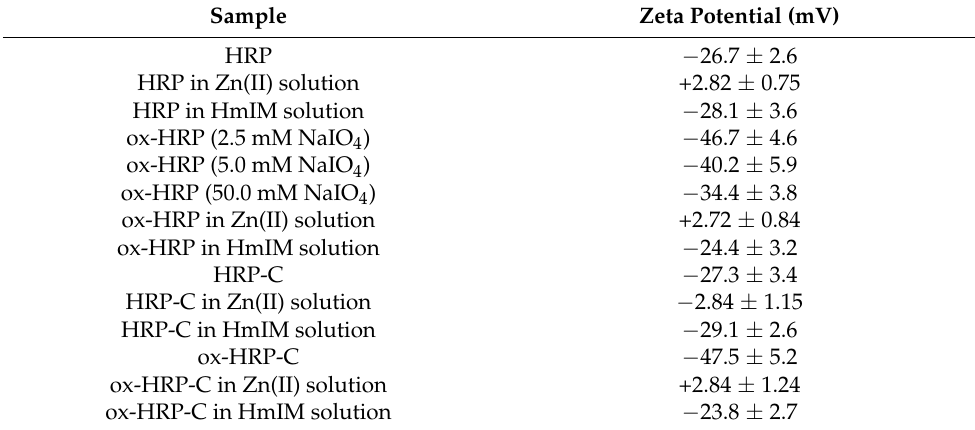
Table 2. Experimental zeta potentials of the tested enzyme solutions. Conditions: 0.35 mg/mL